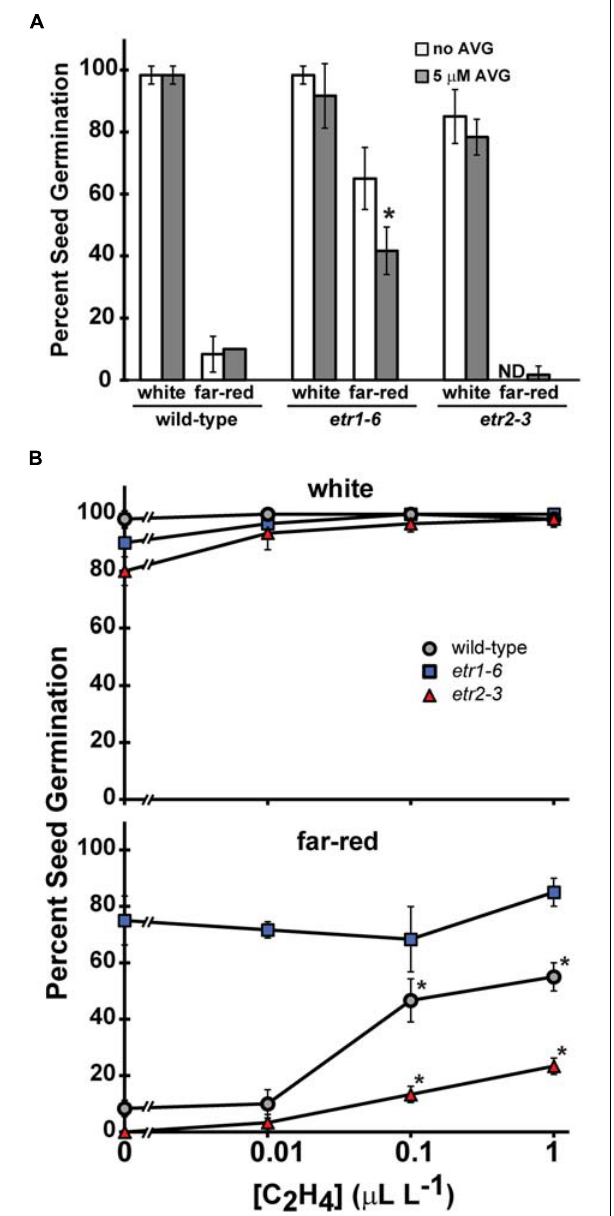
FIGURE 4 |The effects of L - α -(2-amino ethoxyvinyl)-glycine (AVG) and ethylene on seed germination after treatment with far-red light. The number of seeds that germinated after far-red or white illumination was counted and the percent of seeds that germinated was calculated. (A) Seeds on plates containing the ethylene biosynthesis inhibitor, AVG, were treated with far-red light and then germinated for 7 days in the dark. The average ± SD from at least three biological replicates is plotted. ND denotes no germination detected. Data were analyzed by t -tests and differences considered statistically significant with P < 0.05. *Denotes that AVG had a significant effect compared to the non-treated control in that light condition. (B) The effects of increasing concentrations of ethylene as indicated were measured after treatment with white light or far-red light. The average ± SD from at least three biological replicates is plotted. Data were analyzed by t -tests and differences considered statistically significant with P < 0.05. *Denotes that ethylene significantly increased the percent of germination after-far red light over the ethylene untreated